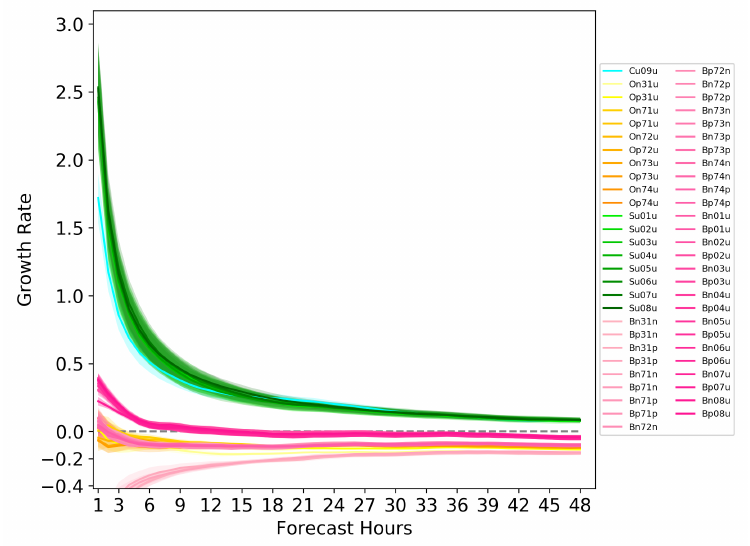
Figure 4. The growth rate of the perturbations for each ensemble member during the simulation period starting at 00Z on 27 February 2017. Light shadings represent the vertical standard